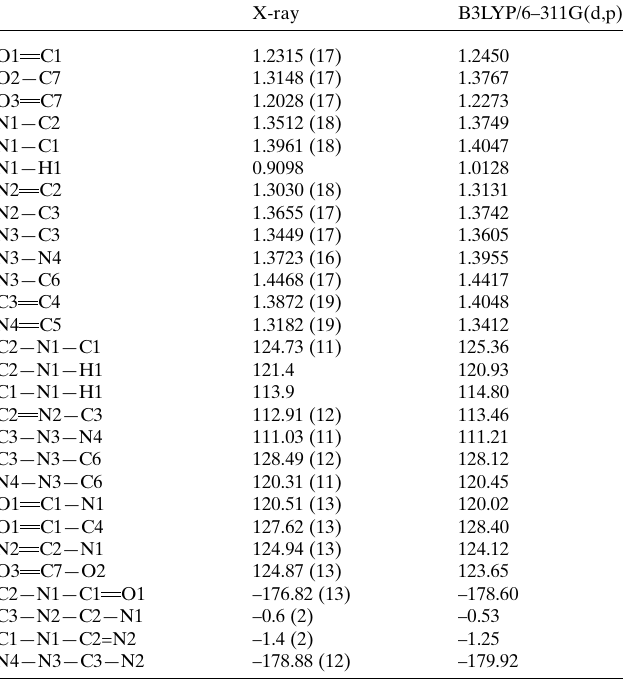
Table 2 Comparison of selected (X-ray and DFT) bond lengths and angles (A˚ , (cid:3)